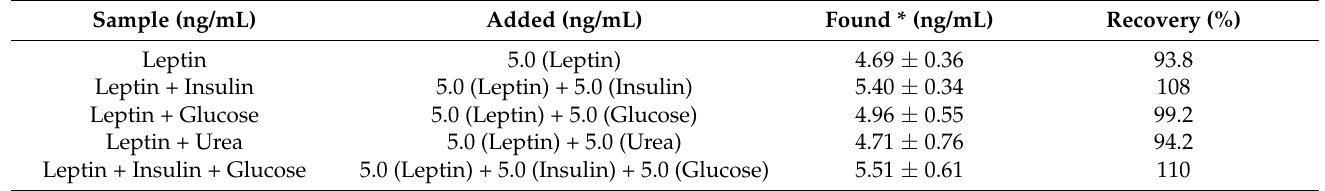
Table 1. Cross-reactivity study indicating biosensor leptin recovery rates in combination with insulin, glucose, and urea. Sample (ng/mL) Added